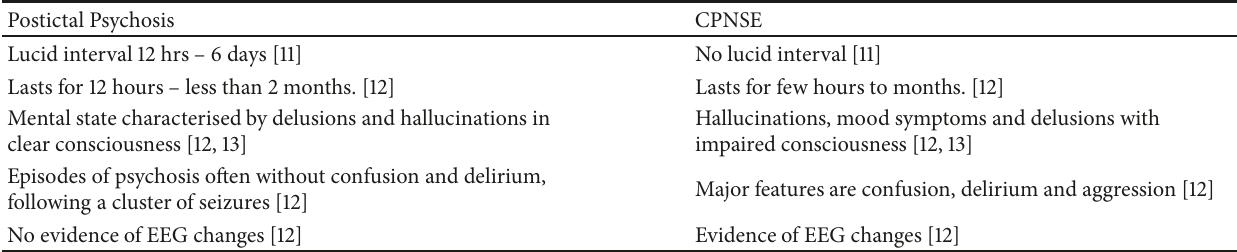
Table 1: Shows contrasting features of postictal psychosis and